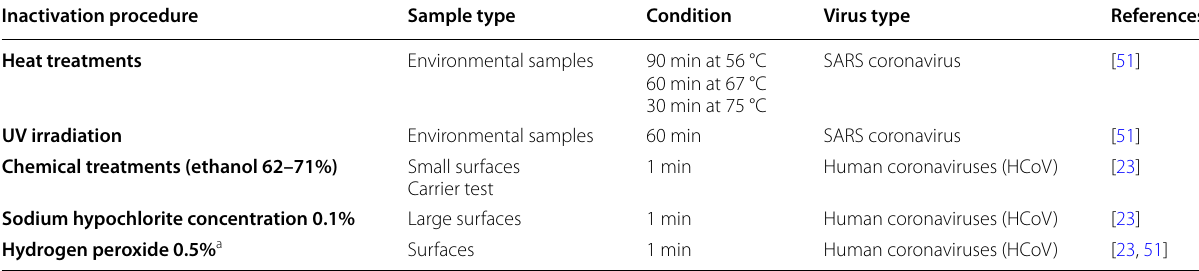
a ECDC technical report, interim guidance for environmental cleaning in non-healthcare facilities exposed to SARS-CoV-2